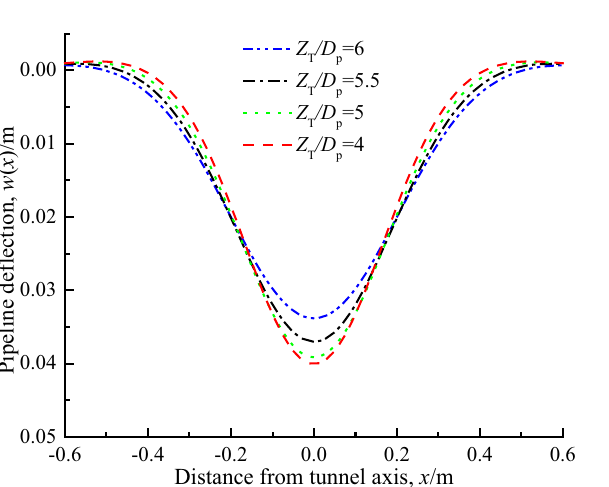
Figure 13. Pipe deflection under different pipe-tunnel